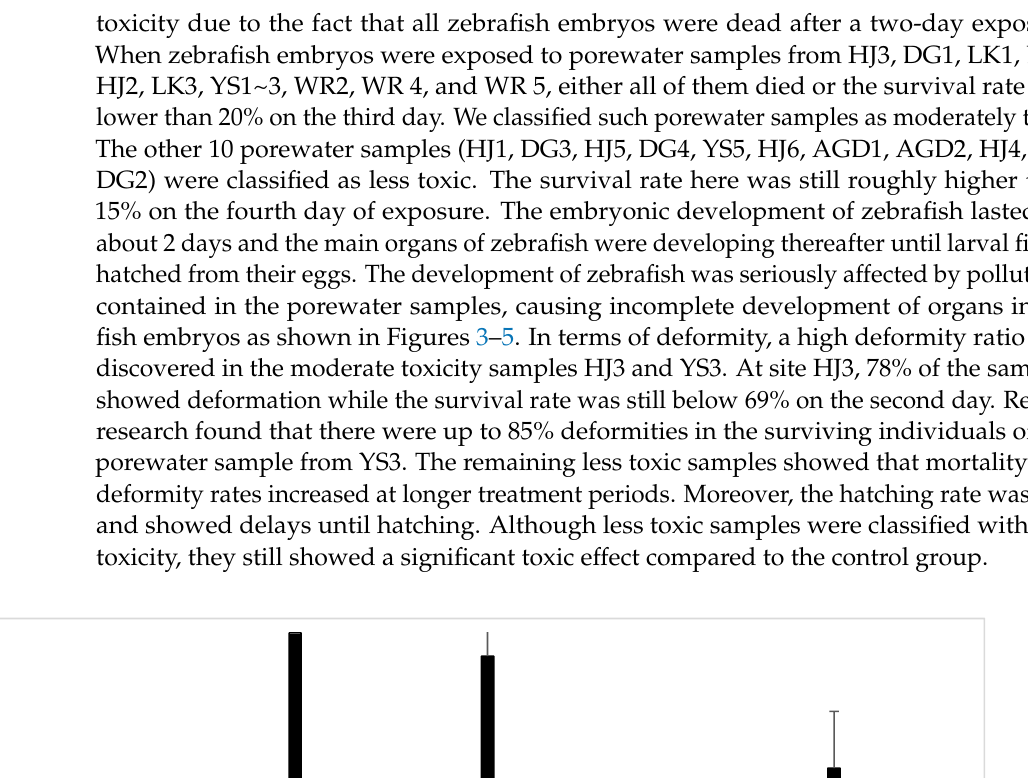
0102030405060708090100 Figure 3. Toxic effects on survival, hatching rate, and deformity rate of zebrafish embryos of river sediment porewater from different sampling sites in Tainan city. Error bars represent standard deviations (n = 3). Figure 4. Toxic effects on survival, hatching rate, and deformity rate of zebrafish embryos of river sediment porewater from different sampling sites in Kaohsiung city. Error bars represent standard deviations (n = 3).